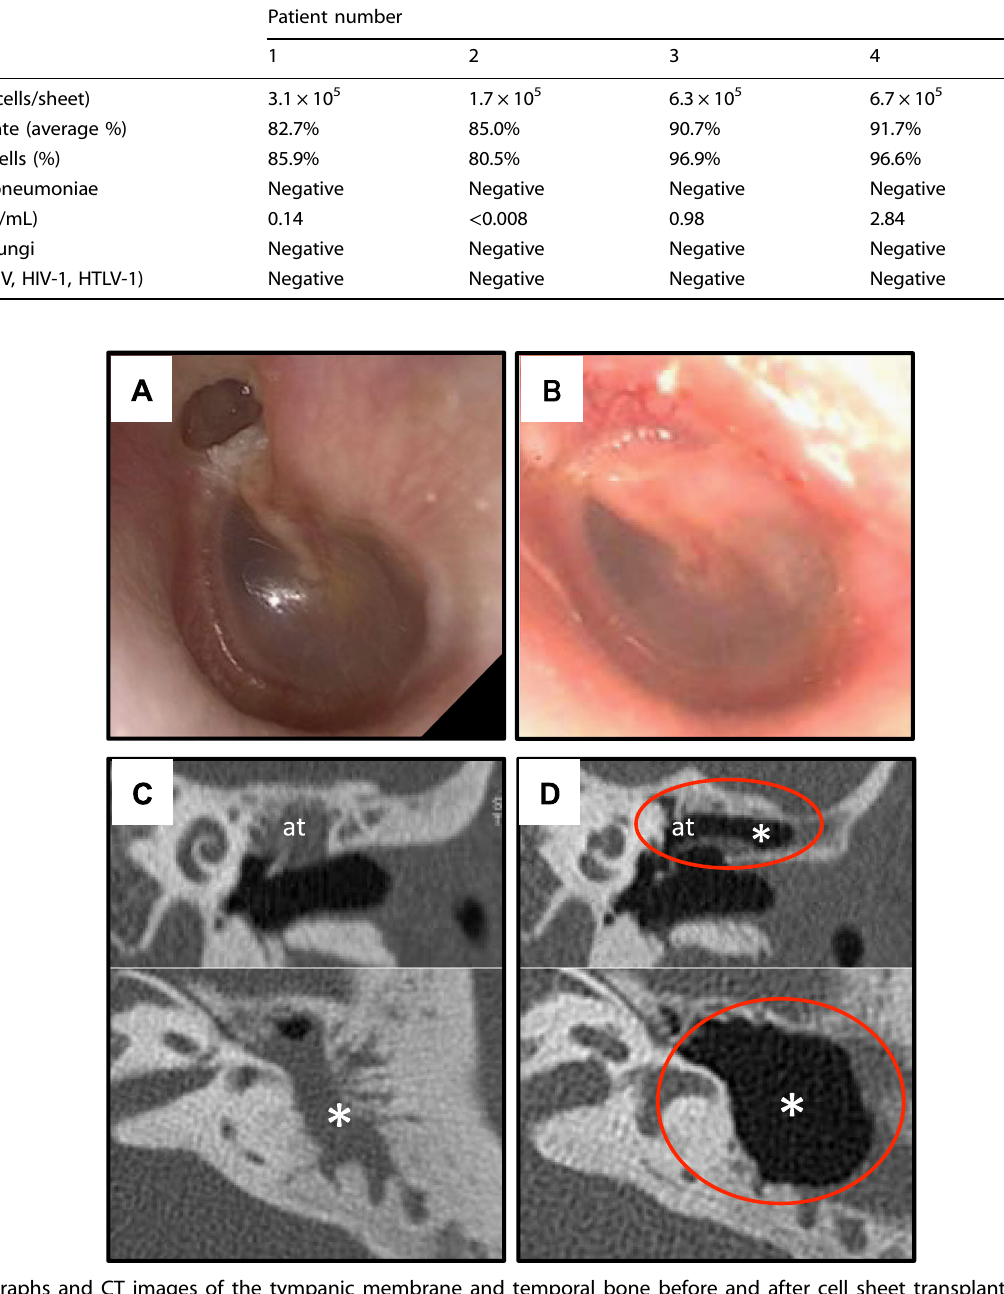
Fig. 3 Photographs and CT images of the tympanic membrane and temporal bone before and after cell sheet transplantation (case 1). a Image of the tympanic membrane before surgery. There is retraction in the attic of the tympanic membrane. The image shows pars fl accida cholesteatoma. b An image of the tympanic membrane 12 months after surgery shows a favorable surgical outcome, without recurrence. c Preoperative CT images of the tympanic cavity and mastoid cavity: the upper image is the coronal view and the lower image is the axial view. Pneumatization is inhibited. There is no air ( black space ) visible in the attic (at) of the tympanic cavity or mastoid cavity (*). d CT images 12 months after surgery: the upper image is the coronal view and the lower image is the axial view. There is a well-pneumatized space in the region between the attic of the tympanic cavity and the mastoid cavity (indicated by red circles). CT: computed